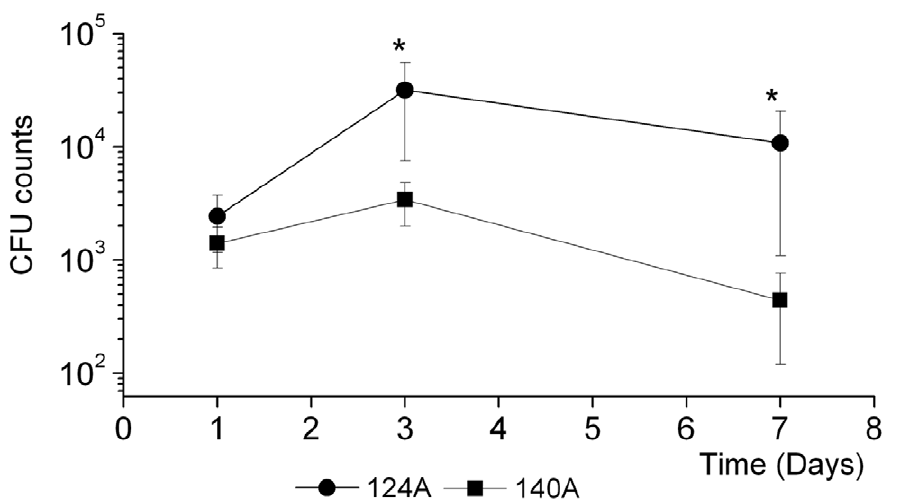
Figure 3. Kidney fungal burden. Groups of four mice infected i.v. with 10 6 C. albicans cells were killed at 1, 3 and 7 days after challenge. Organs were homogenized in HBSS and the suspension diluted and cultured on Sabouraud dextrose agar. Results are presented as log of colony-forming units (CFUs). Statistically significant differences between results at each hour of infection as evaluated by Student’s t test are labeled with single asterisk ( P , 0.05).